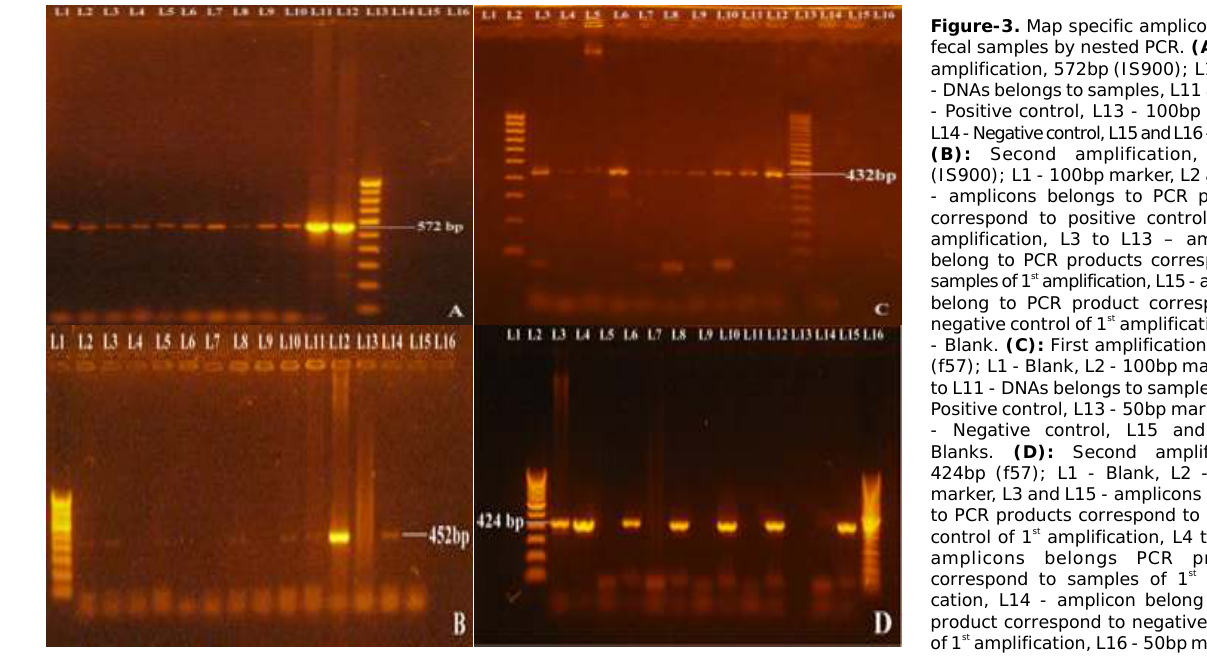
Figure-3. Map specific amplicons from fecal samples by nested PCR. (A):